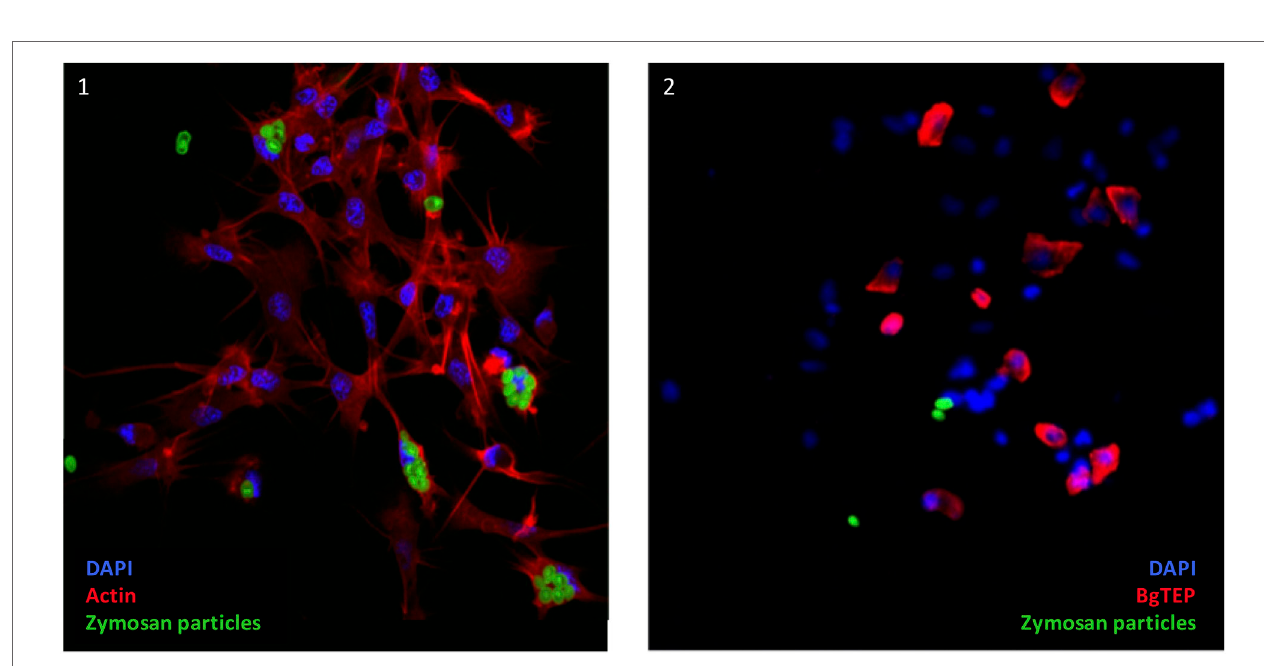
FigUre 7 | Cell-type expression of BgTEP. (a) Immunolocalization of BgTEP in hemocyte populations by confocal microscopy. Three major cell types are present in Biomphalaria glabrata hemolymph: the hyalinocytes with cytoplasmic projections, the granulocytes with granules into the cytoplasm, and the blast-like cells, the smallest cells (Figure S2 in Supplementary Material). Detection of intracellular BgTEP was performed by immunolocalization using the antibody anti-BgTEP-PEP. Alexa-488 phalloidin was used to visualize actin filaments (green) and DAPI for nuclear staining. The red labeling corresponds to BgTEP detection. (B) Flow cytometry profile of BgTEP-positive hemocytes in hemolymph. The total hemocytes are shown according to their size Forward Scatter Channel (FSC) and granularity Side Scatter Channel (SSC). The red dots correspond to BgTEP-positive hemocytes. (c) Flow cytometry quantification of BgTEP-positive cells present in hemolymph. Negative control was performed using the conjugated secondary antibody alone (blue). A fluorescent cutoff was determined to count BgTEP-positive